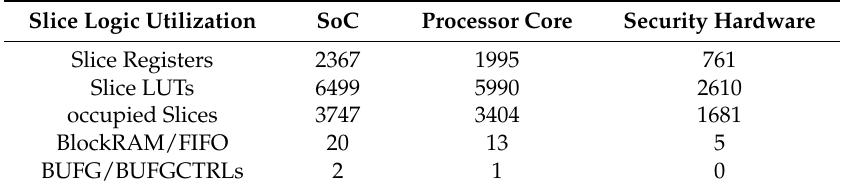
Table 1. The FPGA resources used for the data security enhanced embedded